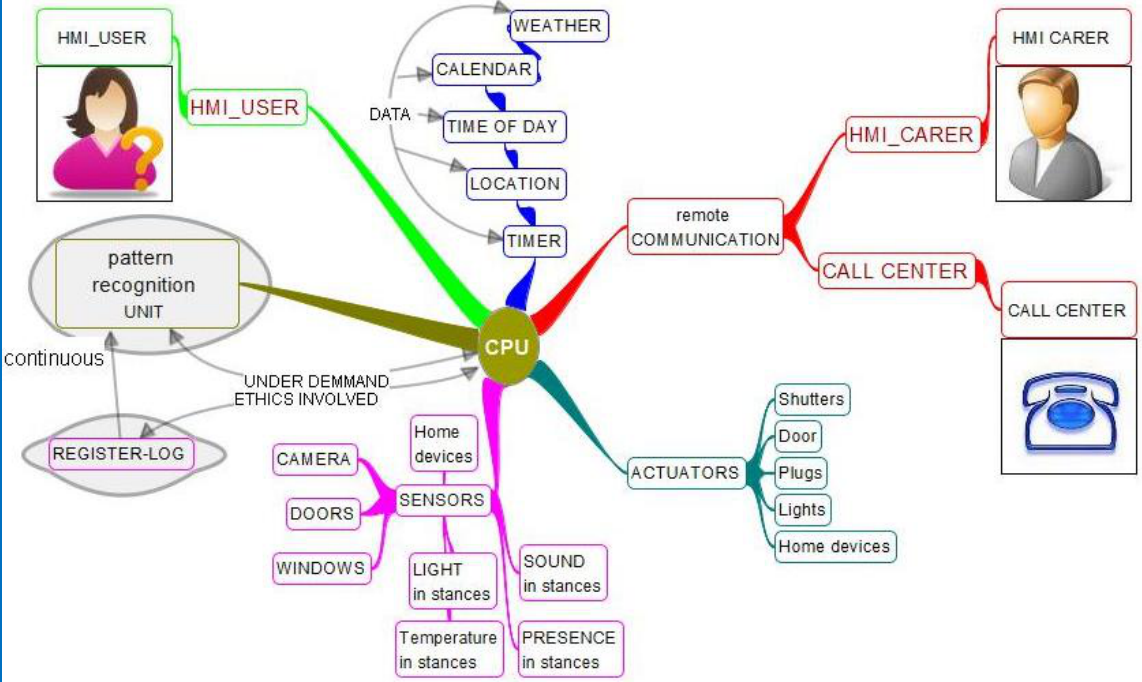
Figure 10. Modular system description for activity and home status supervision